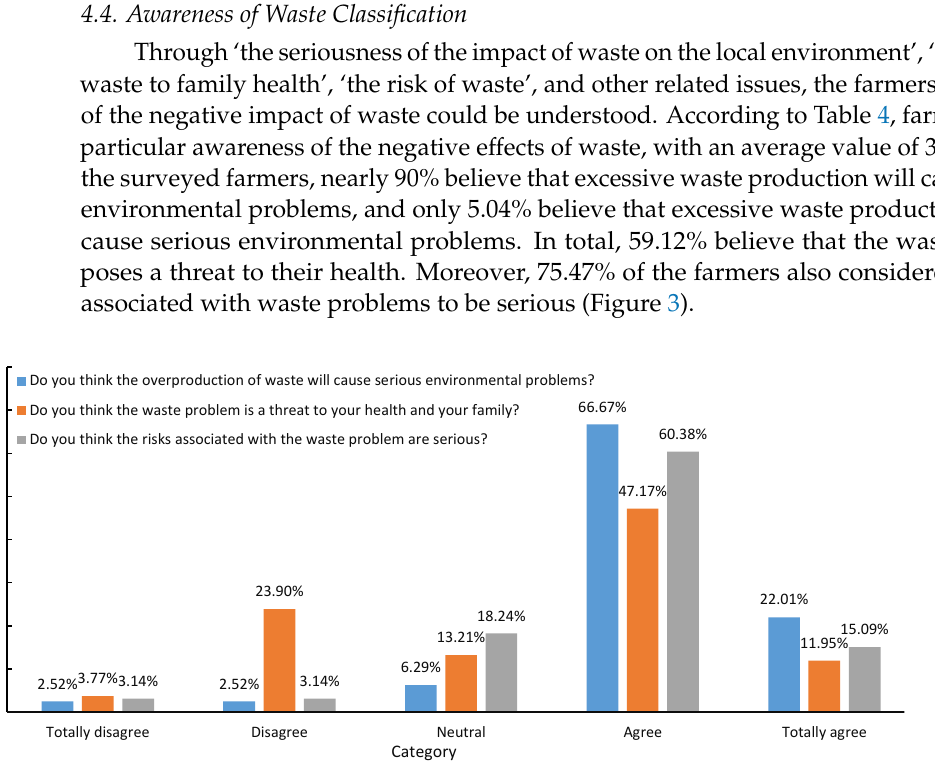
Figure 3. Farmers’ awareness of the negative impact of domestic waste.